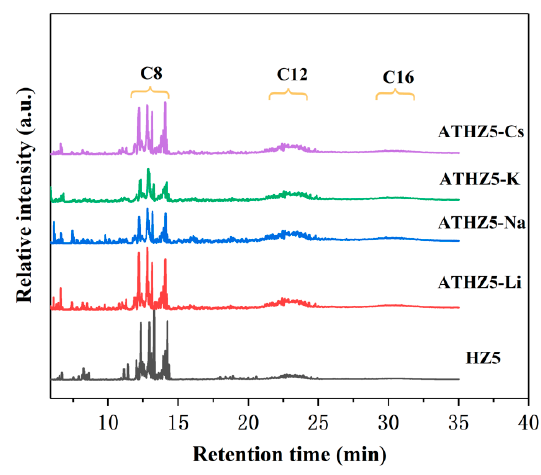
Figure 5. GC chromatograms of liquid products obtained after butene oligomerization at 473 K for 2 h on stream over HZ5 catalyst and modified catalysts.